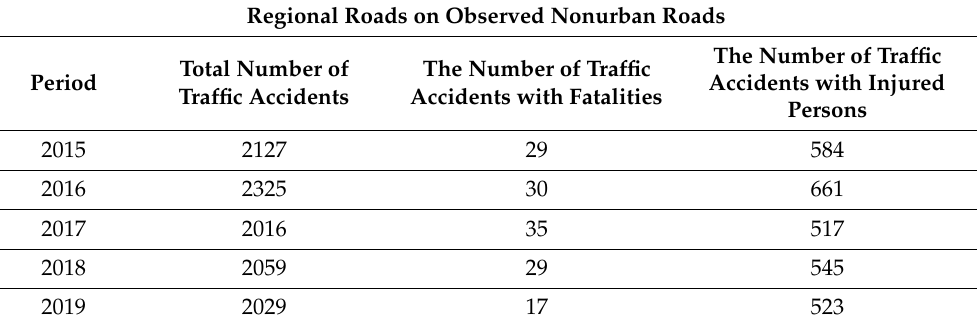
Table 2. Summary data on the number of traffic accidents on the observed